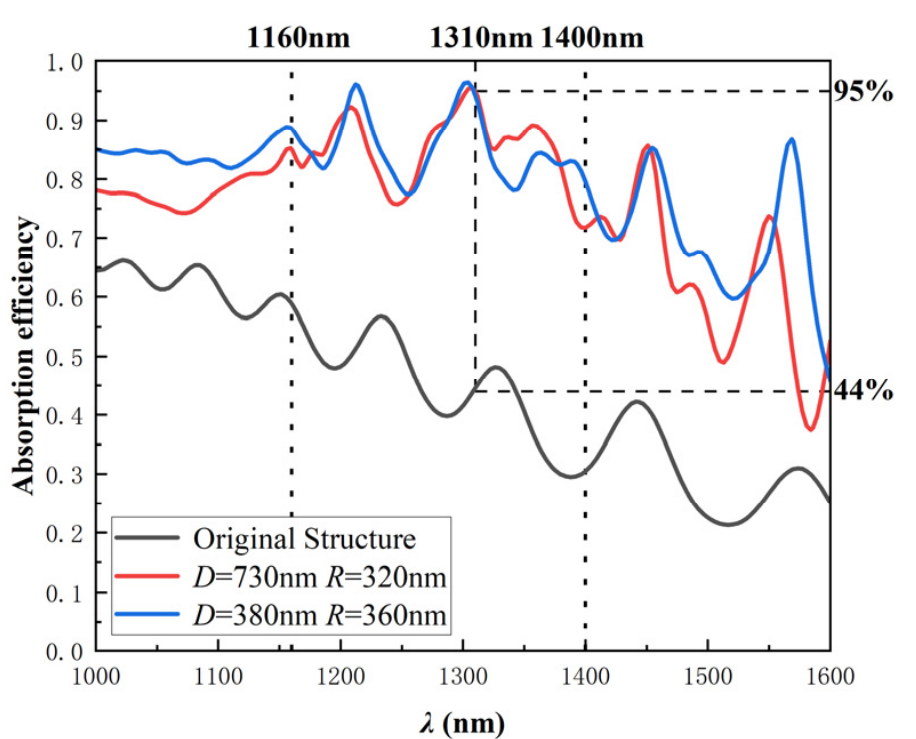
Figure 6. The absorption efficiency of InGaAs/Si APD as a function of the incident wavelength λ = 1~1.6 µ m under different PT-structure conditions.